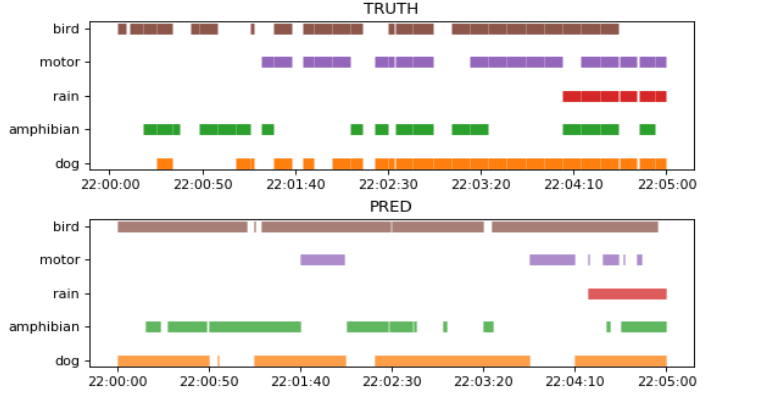
Figure 11. Comparison between manual labeling (truth) and labeling by model (pred).